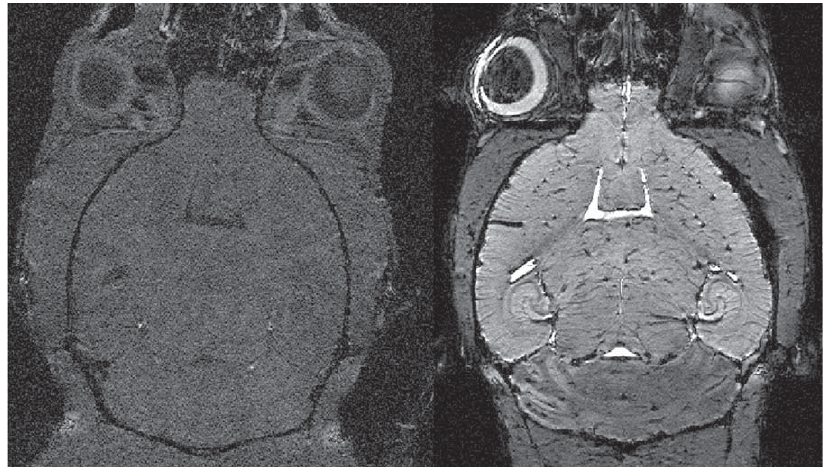
Fig. 9. In Vivo Images of the mouse brain before and after infusion of Gd-DTPA through an opened blood brain barrier. Both images were acquired with the same sequence and parameters: Spoiled gradient recalled image (SPGR), TE=5ms, TR=28ms, flip angle 30 ◦ , BW=15kHz, resolution 40 × 40 × 200 (cid:1) m. Courtesy of Nicholas Laucis, Duke Center for In Vivo Microscopy.